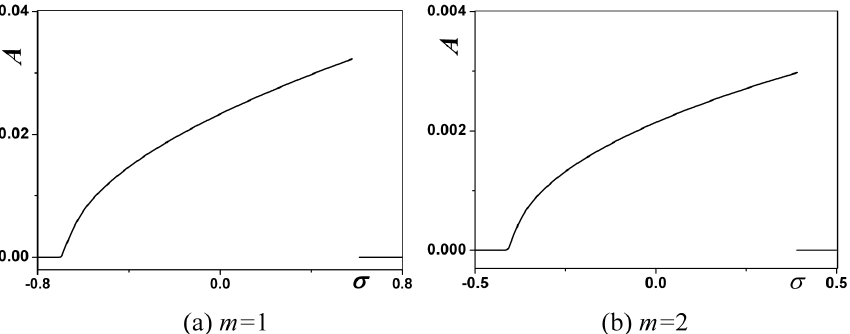
Fig. 8. Amplitudes of stable steady-state responses.